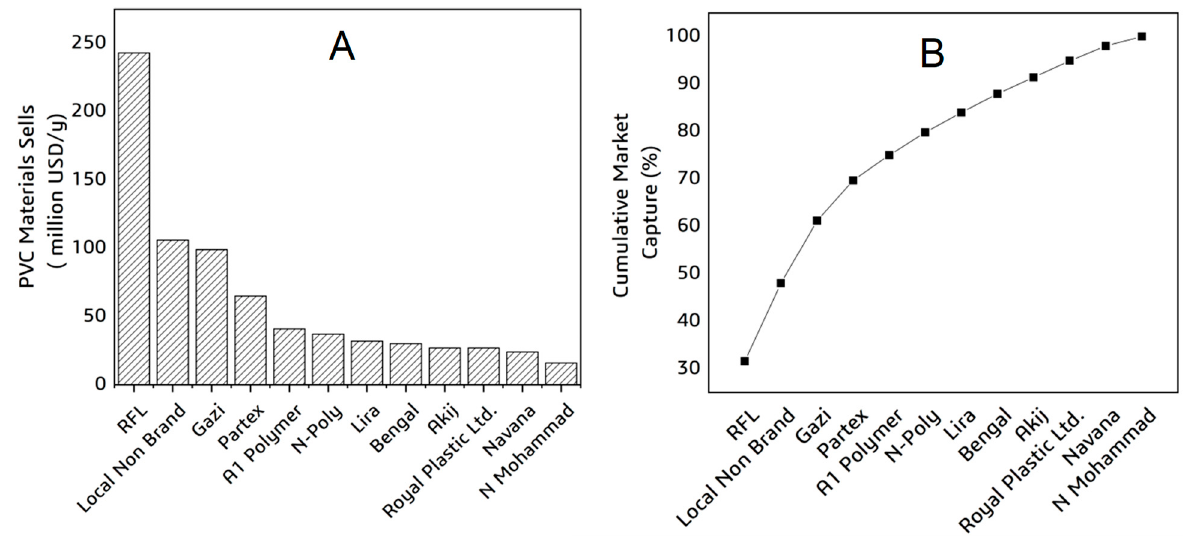
Figure 9. PVC materials sales ( A ) and cumulative market capture in Bangladesh ( B ).